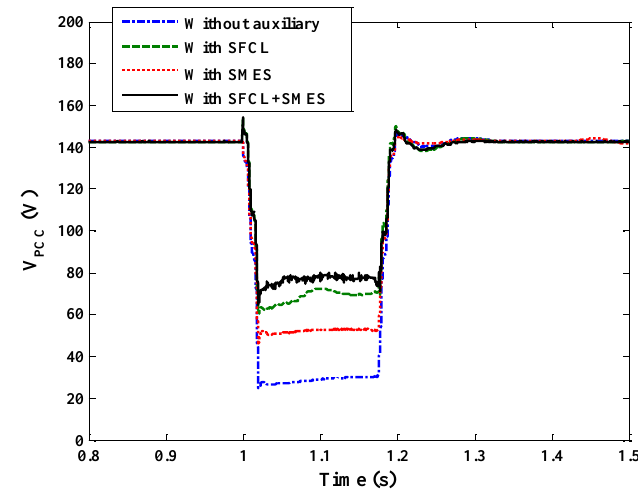
Figure 11. Characteristics of the PCC voltage under the symmetrical fault.